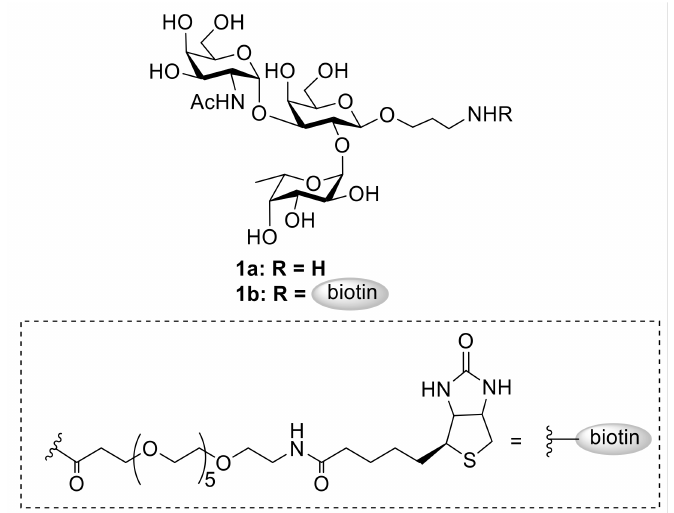
Figure 1. Target spacered A trisaccharide derivatives 1a and 1b